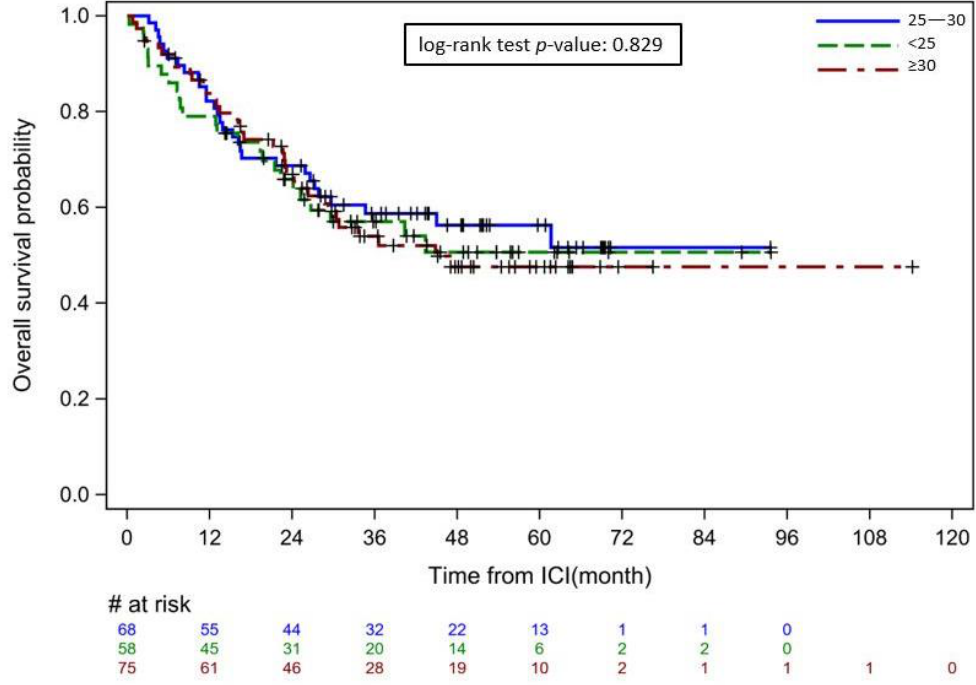
Figure 3. Overall survival of patients with immune-mediated diarrhea and colitis by BMI group Starting point: immune checkpoint inhibitor initiation. Ending point: last follow-up or death from any cause. # refers to the number of patients at risk, + indicates cases censored due to loss to follow-up.